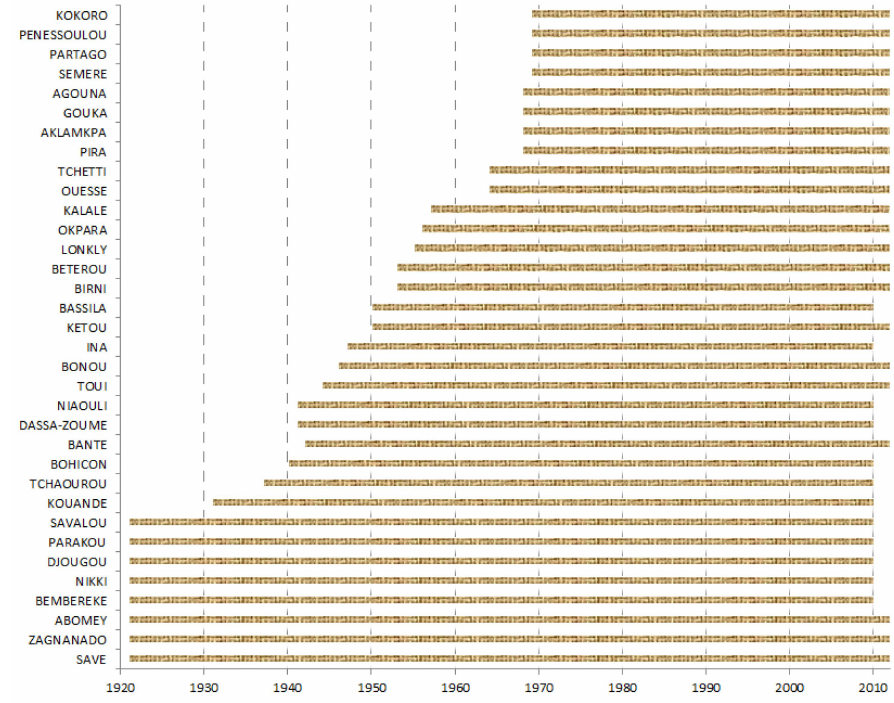
Figure 1. Data range for each station. For the spatial distribution of the stations see Figure